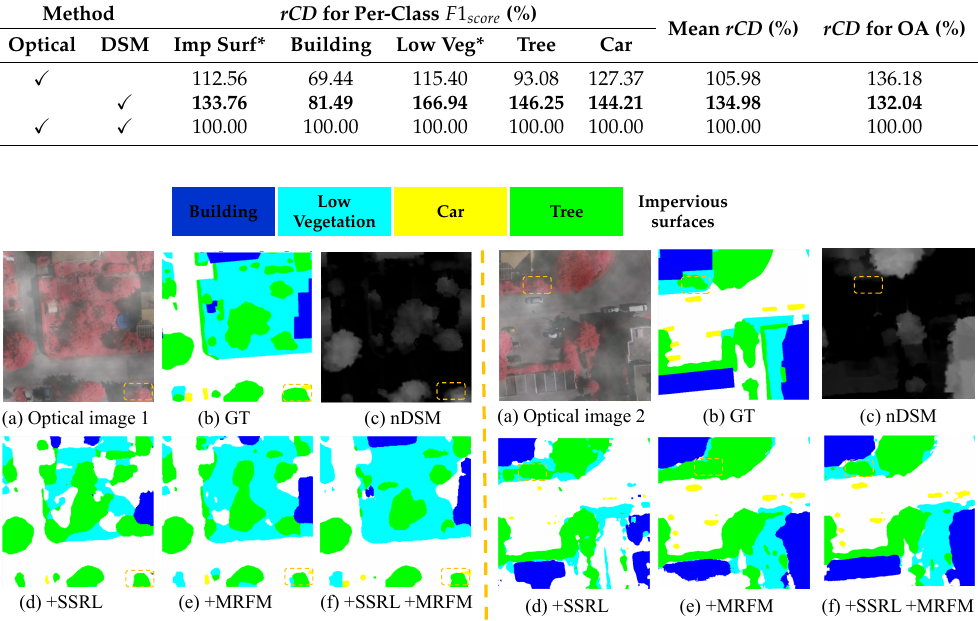
Figure 7. Illustrations about some ablation results of each component in the framework. In this case, optical images are corrupted by fog, which belongs to severity level